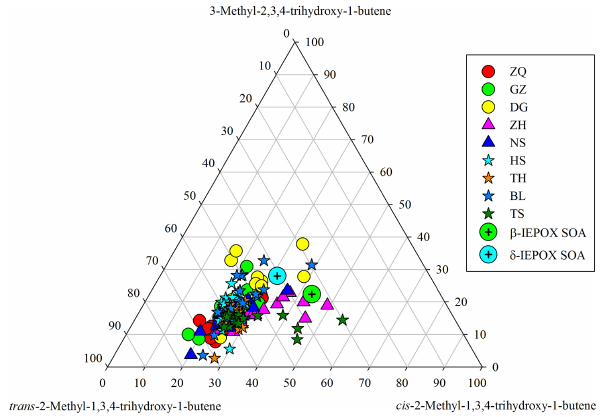
Figure 7. Ternary plot of C 5 -alkene triol isomers in the PRD sam- ples and in the β -IEPOX- and δ -IEPOX-derived SOA (Lin et al.,